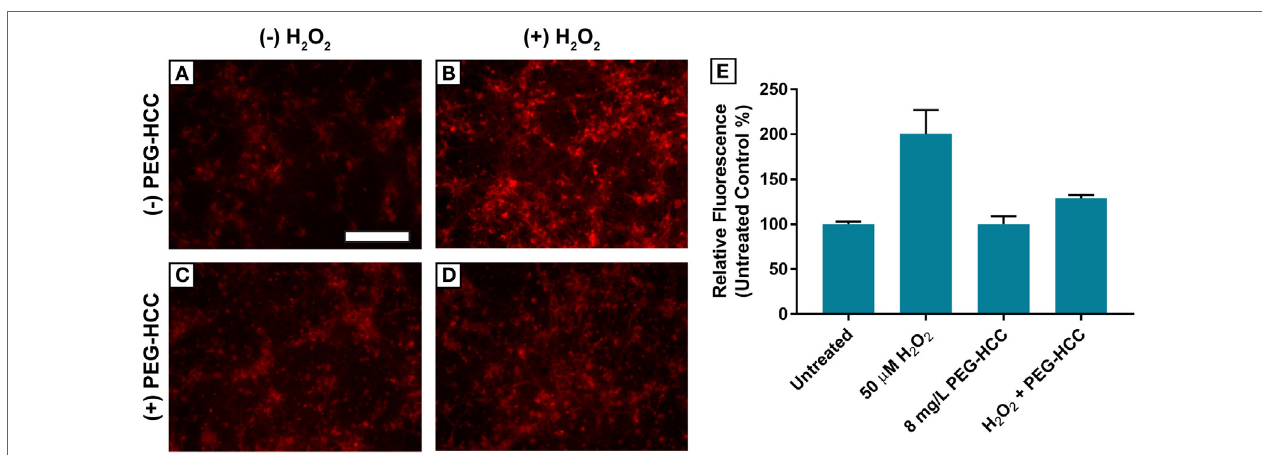
FigUre 3 | Hydrophilic carbon clusters, conjugated to poly(ethylene glycol) (PEG-HCCs) reduce the oxidation of CellROX fluorescent dye in primary murine cortical neurons by hydrogen peroxide. (a) MCNs (50,000 cells/well) untreated. (B) MCNs treated with 50 µM H 2 O 2 for 45 min. (c) MCNs treated with 8 mg/L PEG-HCCs for 45 min. (D) MCNs treated with 50 µM H 2 O 2 for 15 min followed by the addition of 8 mg/L PEG-HCCs for an additional 30-min exposure. (e) Untreated control normalized fluorescence of oxidized CellROX dye. Total cell counts per condition: untreated ( n = 137), 50 µM H 2 O 2 ( n = 158), 8 mg/L PEG-HCC ( n = 150), and H 2 O 2 + PEG-HCC ( n = 139).